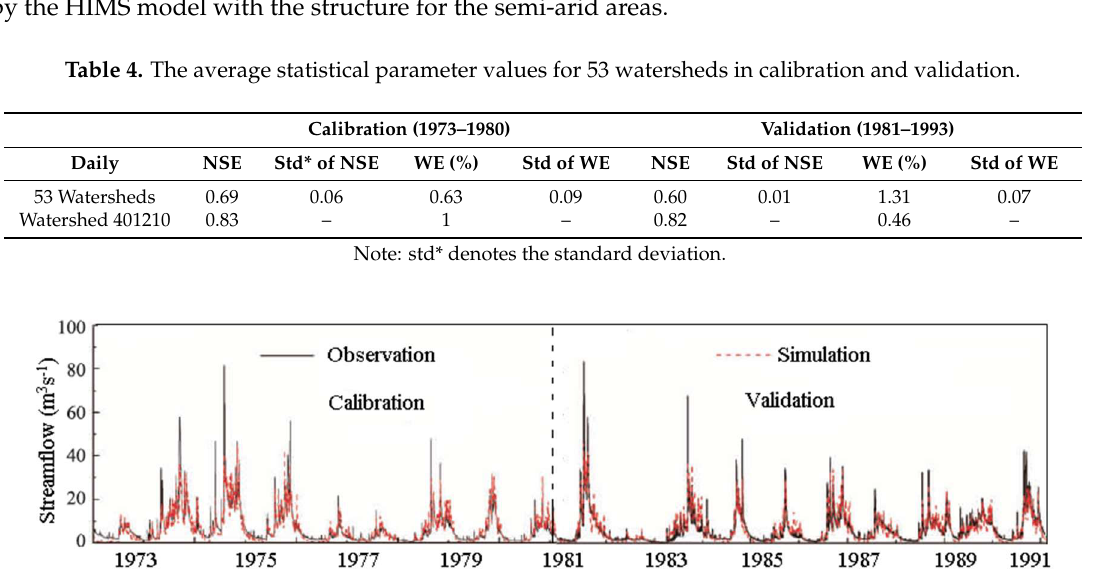
Figure 5. Daily streamflow comparison between simulation and observation for the watershed 401210.